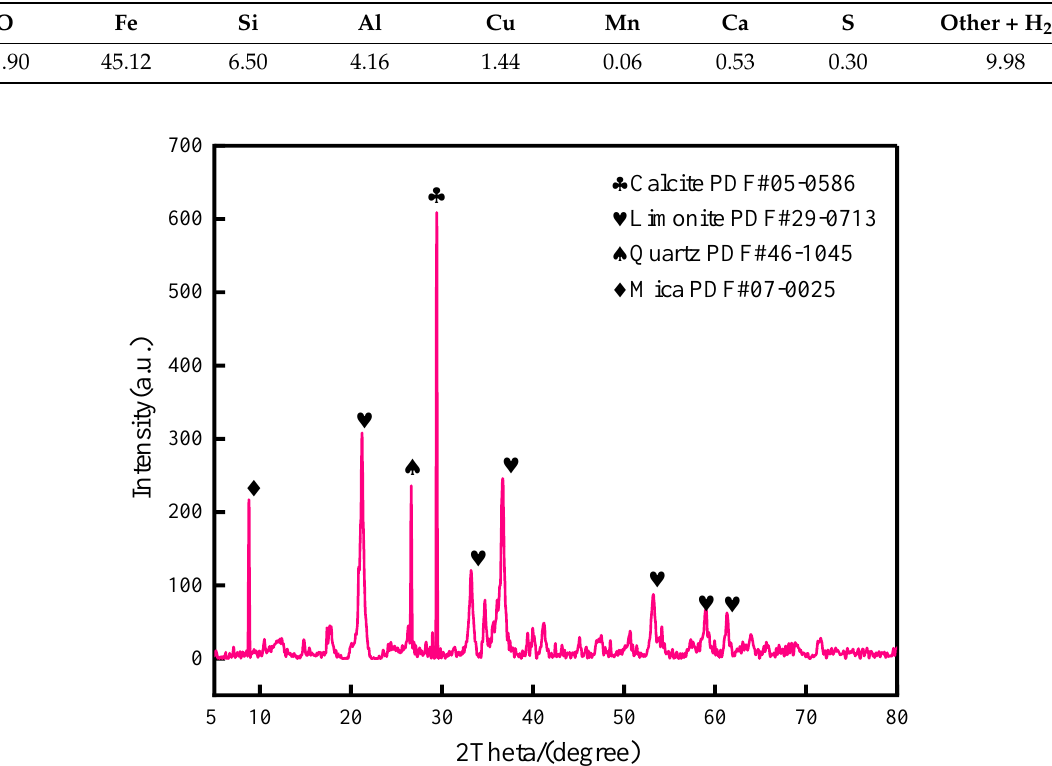
Figure 1. X-ray diffraction (XRD) pattern of the COBL ore.